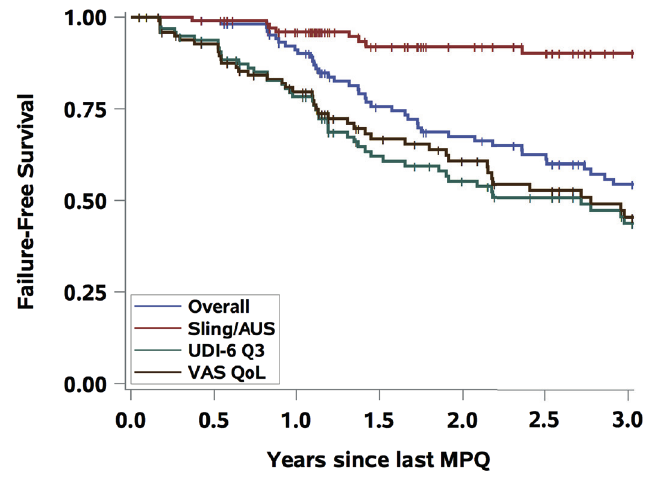
Figure 2 - The red line represents the 10 patients who proceeded to Sling/AUS after last MPQ injection. The remaining three lines represent the entire